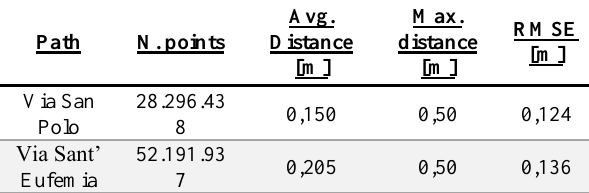
Figure 16. Potree’s interface of Via San